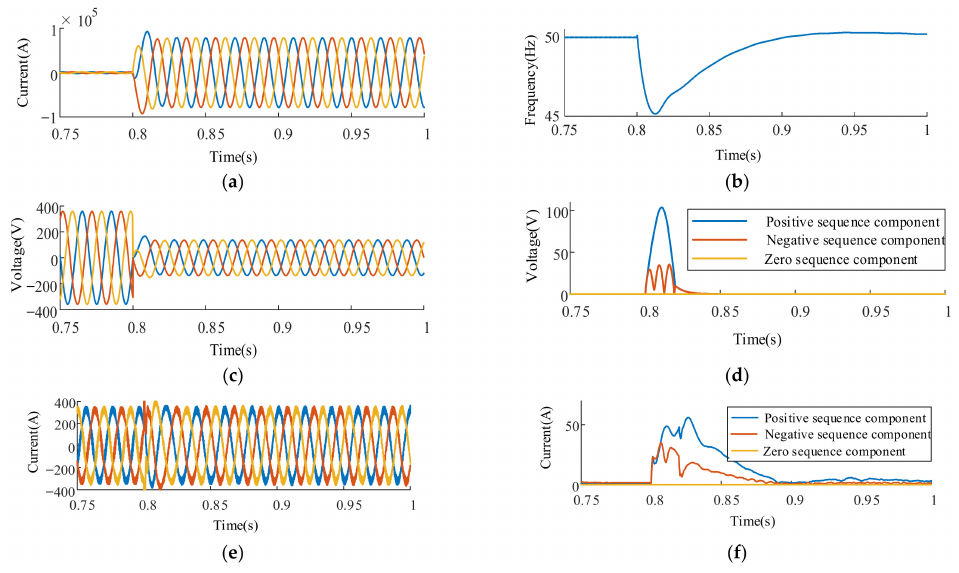
Figure 5. Simulation waveforms of the PCC three-phase short circuit: ( a ) The current flowing into the grid; ( b ) System’s voltage frequency; ( c ) The voltage at the PCC; ( d ) The second harmonic sym- metrical components of the measured voltage; ( e ) Inverter output current; ( f ) The second harmonic symmetrical components of the measured current.